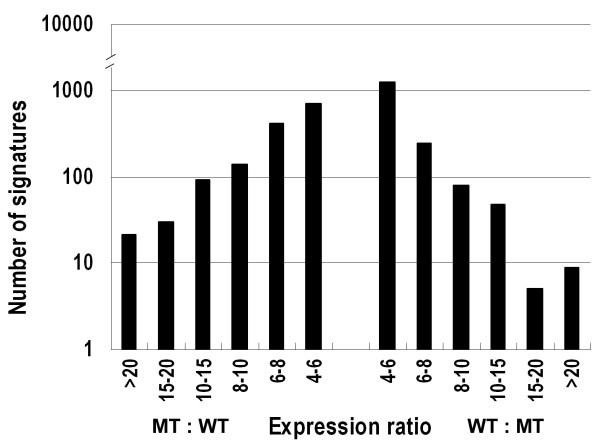
Comparison of expression of the MPSS signatures between the mutant and the wild type. The expression ratios compare the abundance of each signature between mutant and wild type. Columns denote the number of signatures with an expression ratio within the stated range.